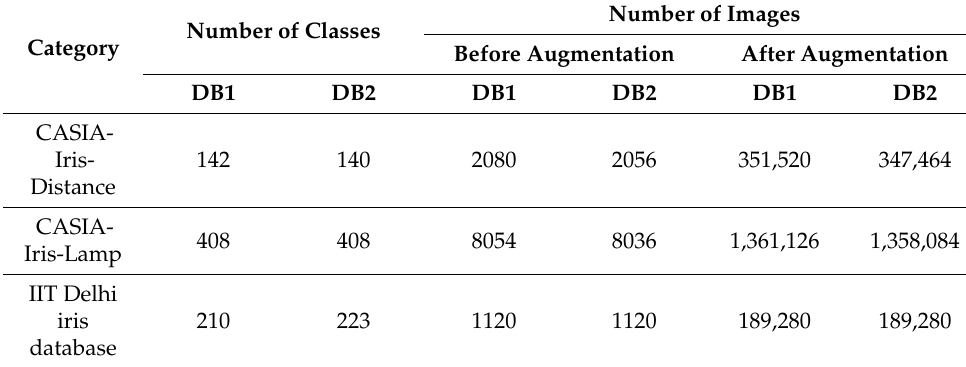
Table 4. Detailed descriptions of the experimental